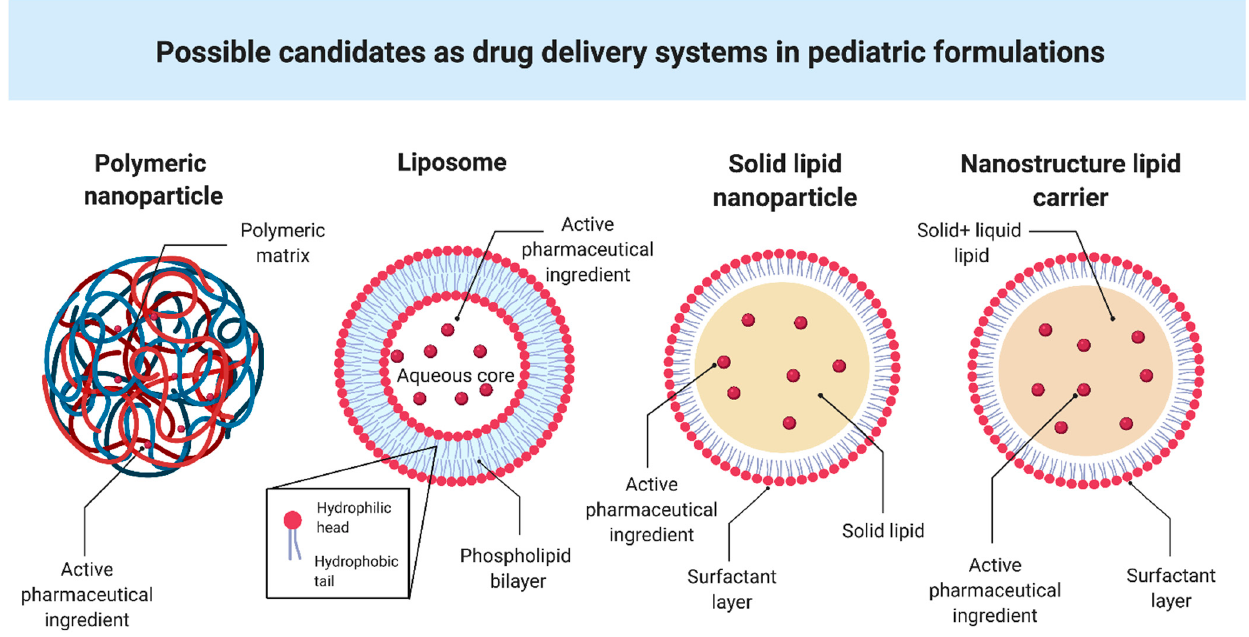
Figure 2. Schematic representation of possible candidates as drug delivery systems in pediatric formulations. It was created with Biorender (https://biorender.com/ accessed on 27 April 2021).